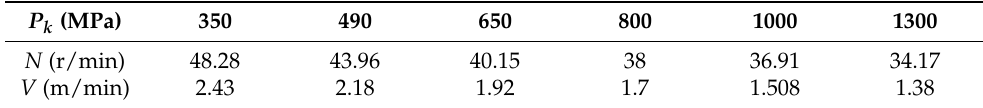
Table 5. Motion parameters after